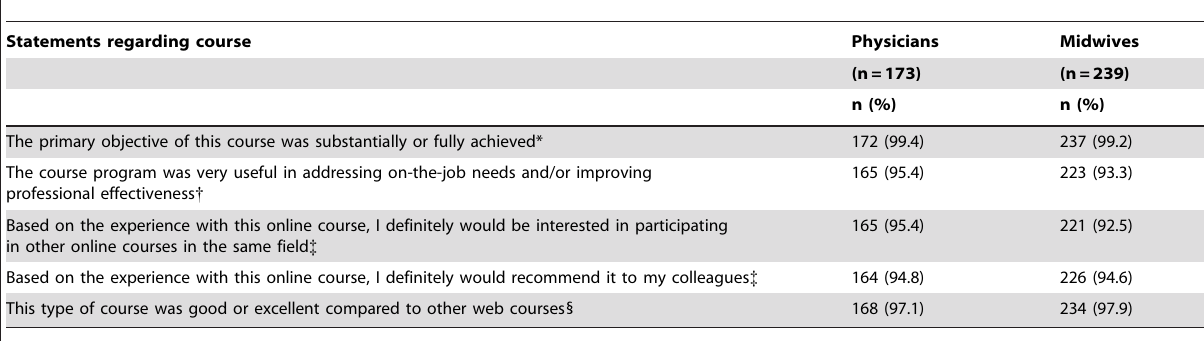
Table 4. Participants’ satisfaction with the STD Internet-based CE